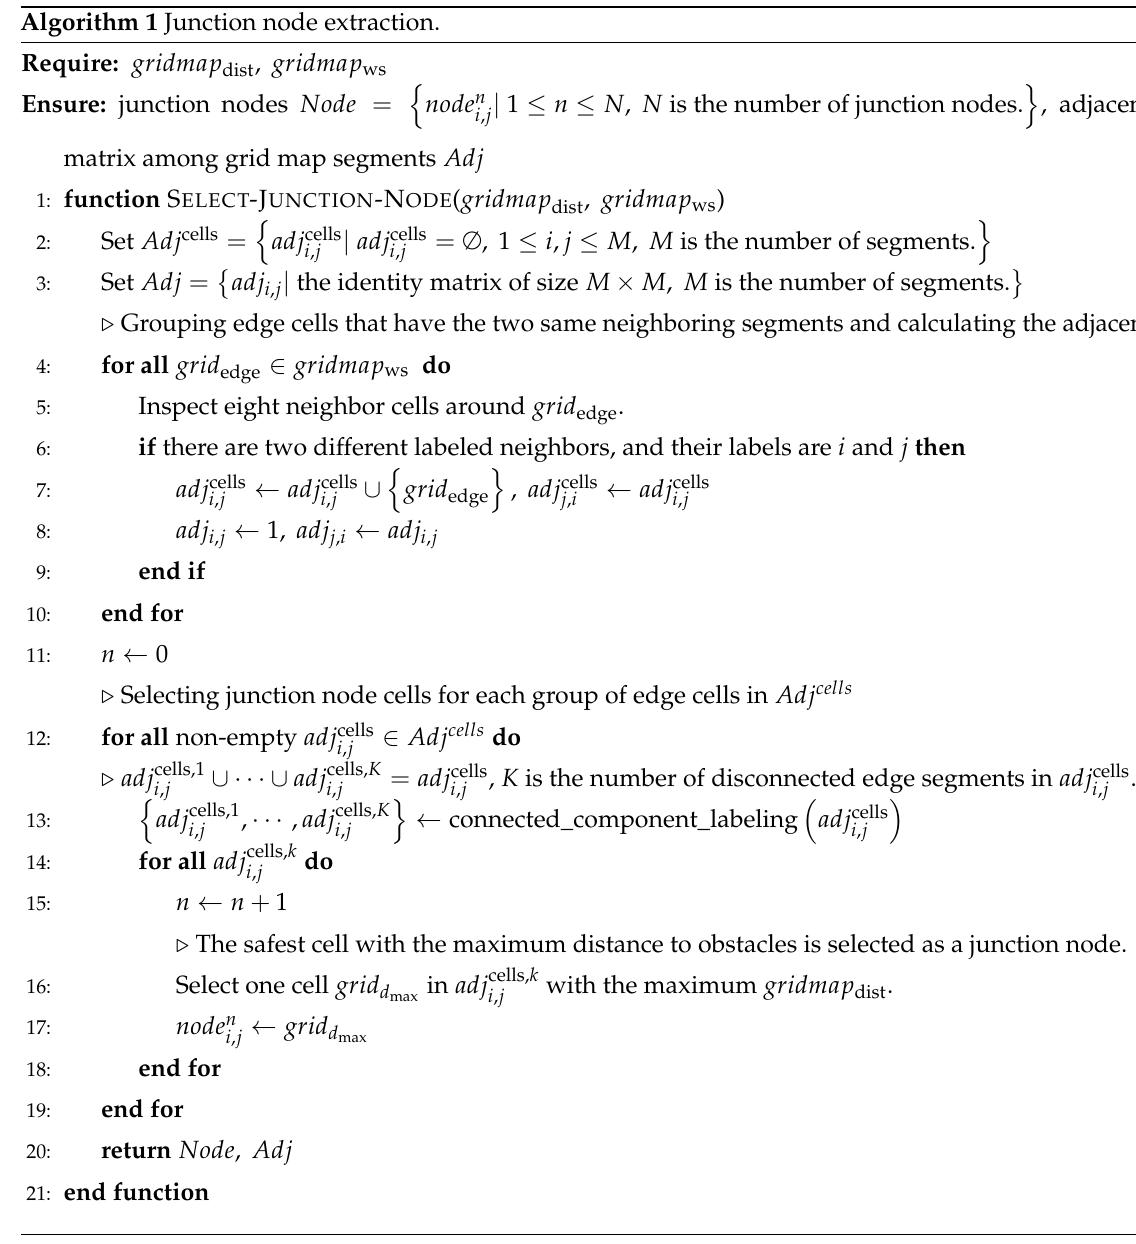
Algorithm 1 Junction node extraction.